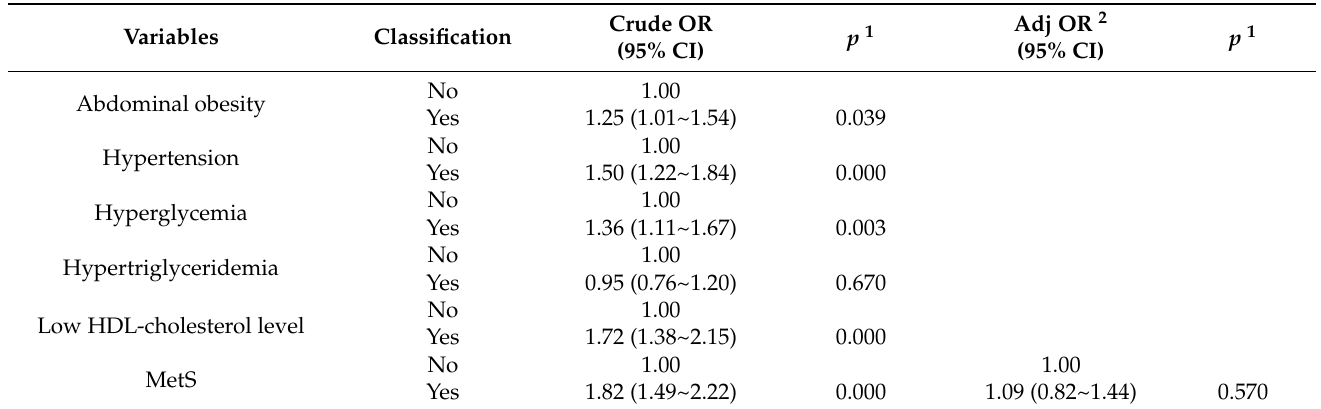
Table 4. The association between MetS and the number of remaining teeth less than